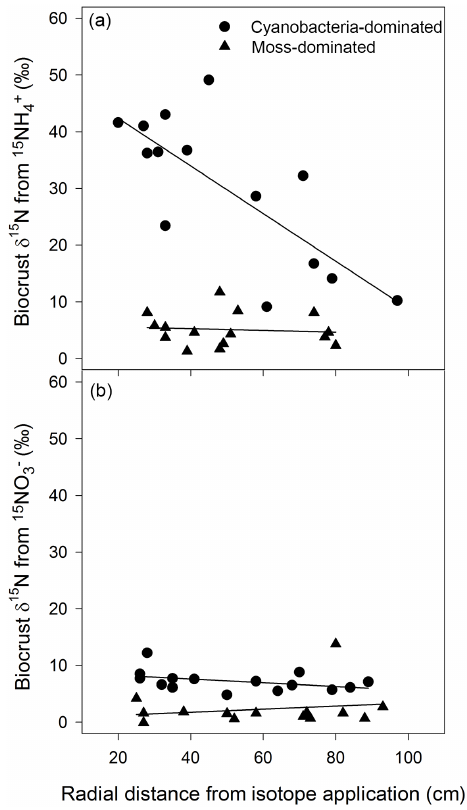
, was diluted as the 4